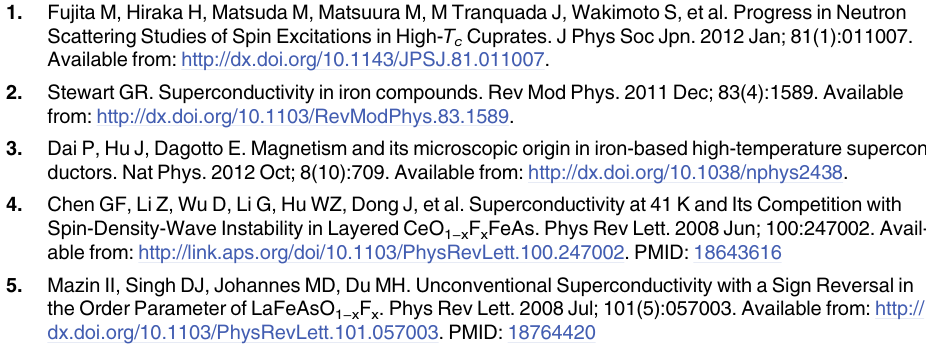
For different magnetic ordering patterns studied (see text), the resulting magnetic moments m , energies and density at the Fermi surface N ( E F ) in units of eV − 1 per formula unit. The energy of paramagnetic case (NSP) is taken to be